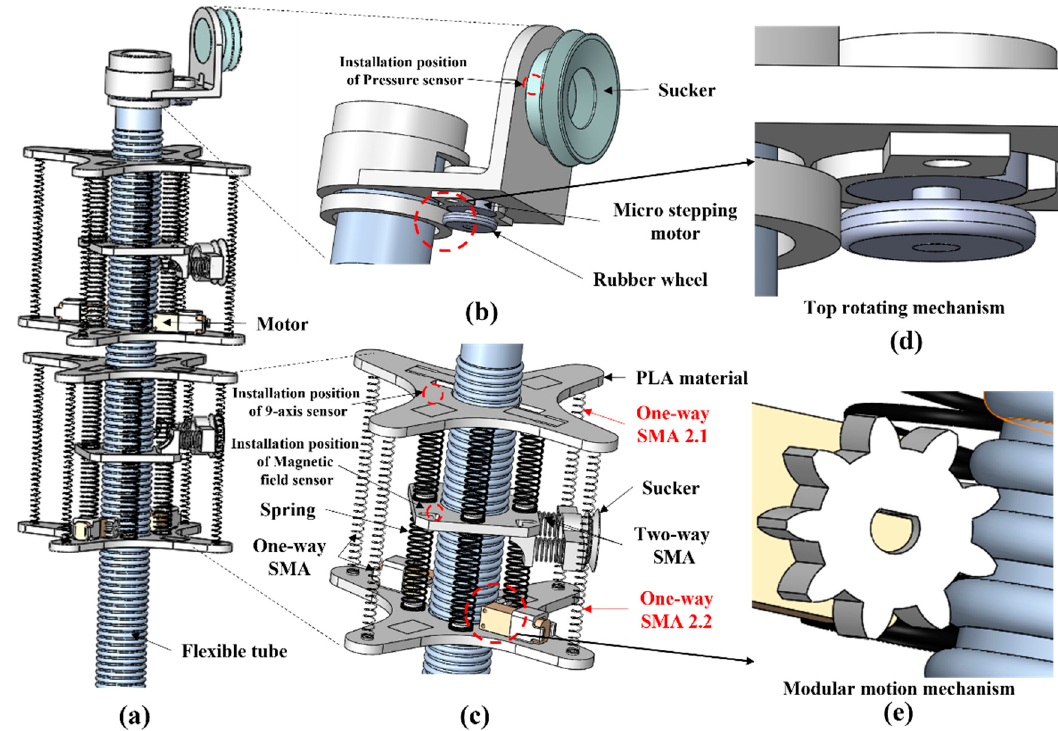
Figure 2. Schematic diagram of ISB-MWCR. ( a ) Overview. ( b ) Rotary adsorption structure of robot head. ( c ) Modular unit of robot. ( d ) Top rotating mechanism. ( e ) Modular motion mechanism.